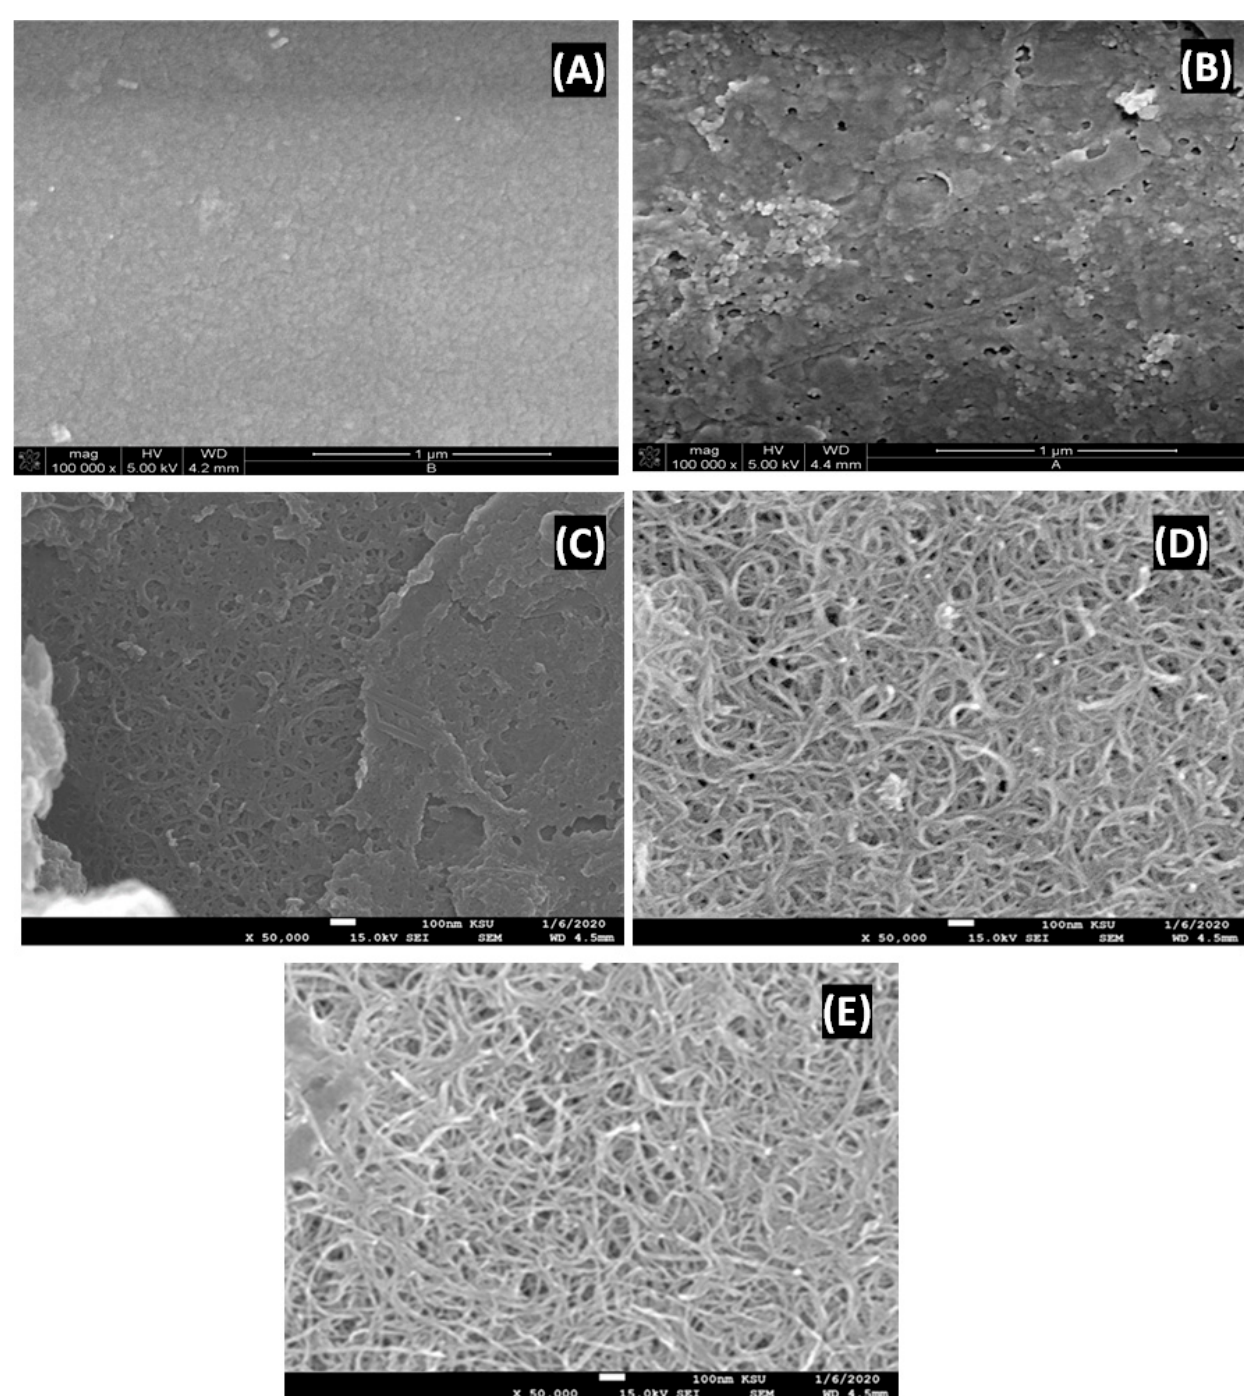
Figure 2. SEM images of the five PSf membranes: chitosan ( A ), CHIT- G ( B ), CHIT-G/MWCNT ( C ); CHIT-G/MWCNT-COOH ( D ) and CHIT-G/MWCNT-NH 2 ( E ).